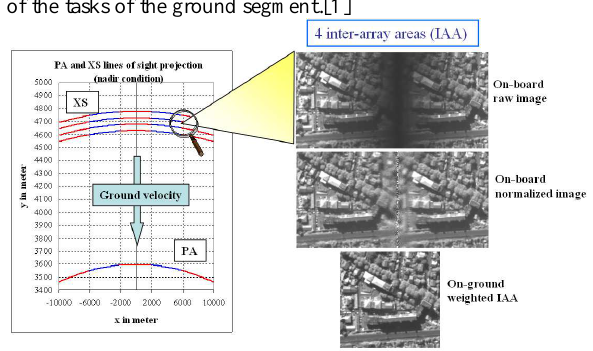
Figure 9: image reconstruction Image chain The video data are compressed on-board thanks to the Payload Data Compression Unit and then transmitted to the ground with a 4.5 Gbits/s output rate. A wavelet transform algorithm is used, enabling compression rates at 2.8 bits per